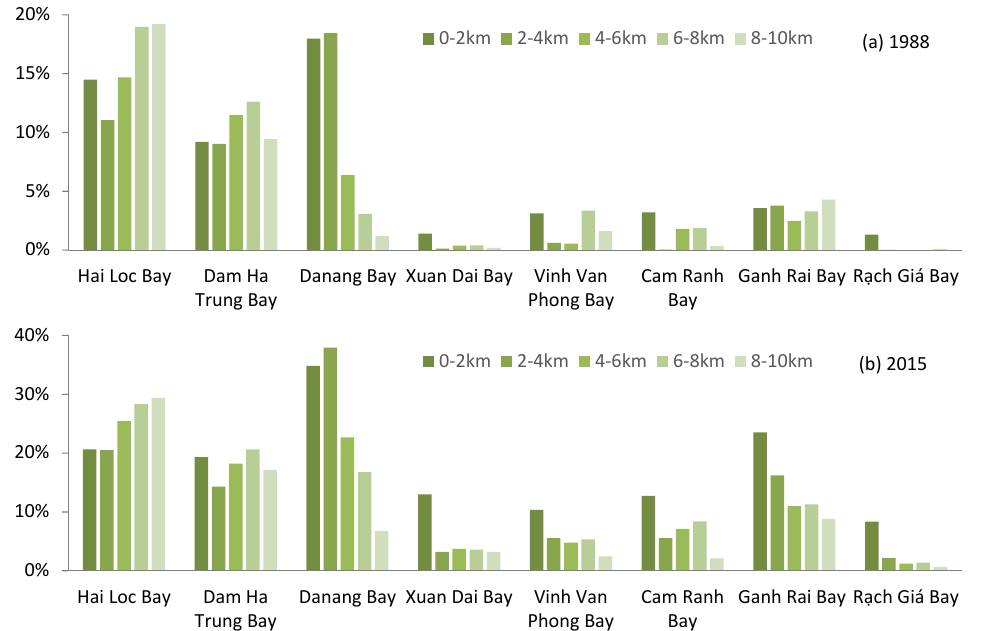
Figure 7. Proportion of construction land in each zone in each bay. ( a ) Proportion of construction land in 1988; ( b ) Proportion of construction land in 2015.